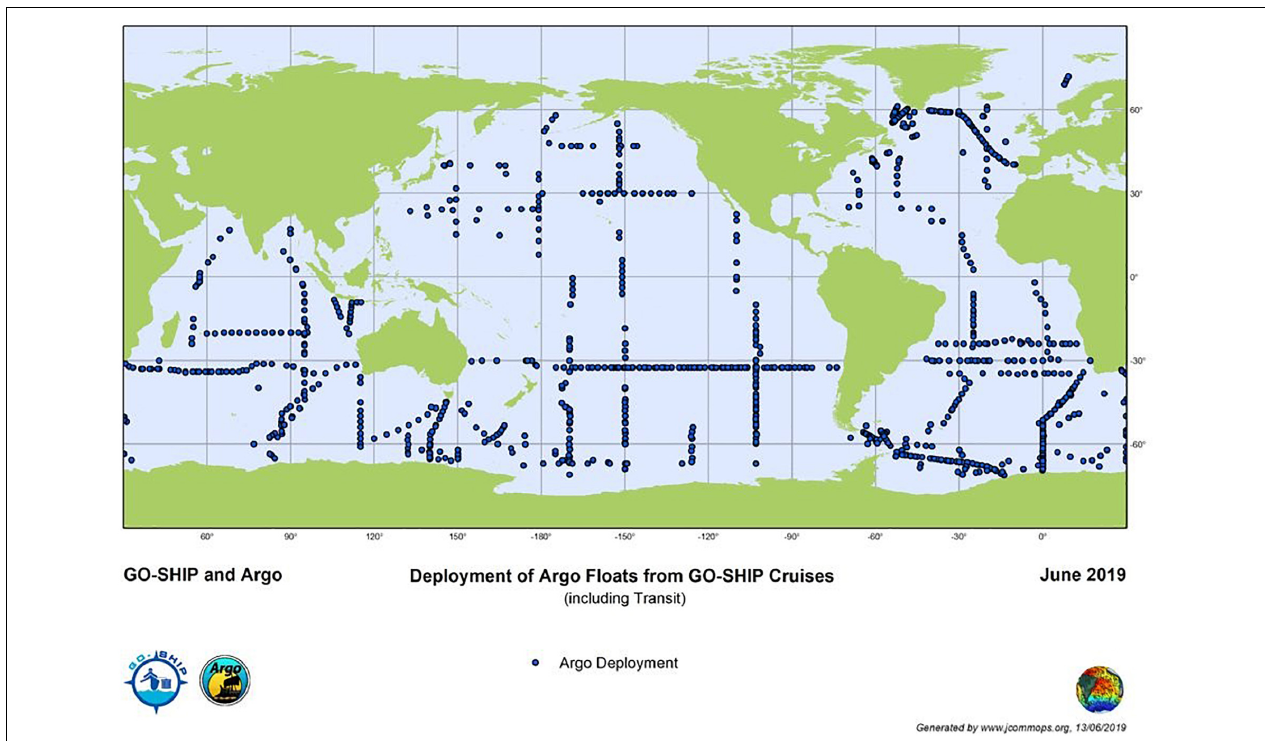
FIGURE 4 | Deployment locations of more than 1100 Argo floats from GO-SHIP cruises from 2002 to 2019 (www.jcommops.org). The 7% deployment rate of Argo floats on GO-SHIP cruises during that time period is likely conservative, as required metadata for such an analysis are not always available Many GO-SHIP deployments are in remote locations outside commercial shipping lanes, making GO-SHIP cruises an important means to cover the global